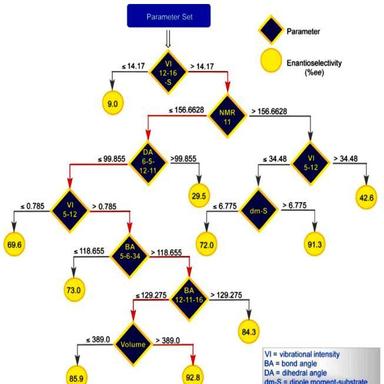
Decision tree analysis for 368 reactions. The discriminating attribute at the higher level in a decision tree has a more pronounced impact on the outcome while the lower attributes tend to exert differing influences depending on the preceding set of attributes in that branch. The paths shown in red convey the combination of descriptors for the most promising substrate–catalyst combinations. Reproduced with permission from National Academy of Sciences. (For interpretation of the references to colour in this